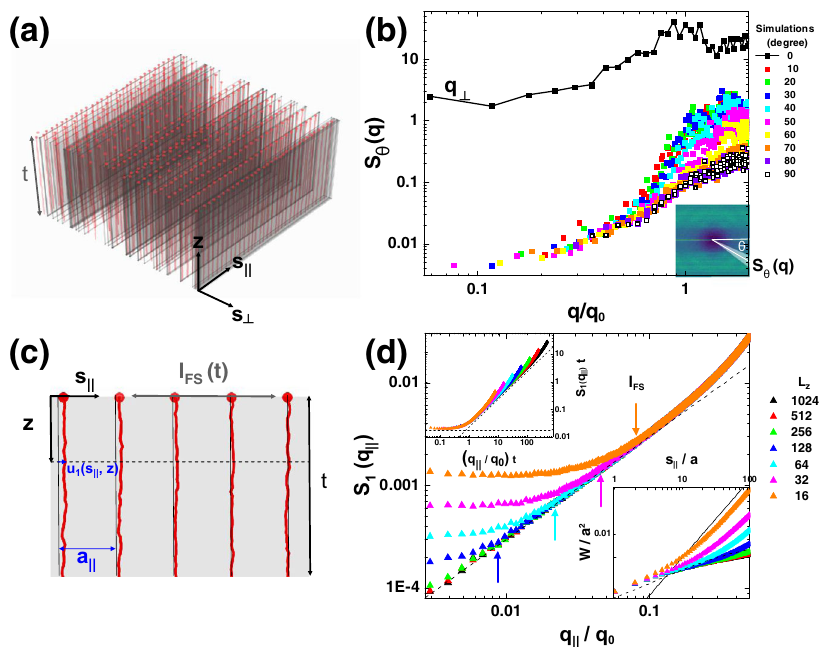
Fig. 5 Simulations of a structure of interacting elastic vortex lines in samples with planar defects. a Snapshot of a quenched con fi guration obtained from three dimensional Langevin dynamics simulations of interacting vortices (red lines) in presence of parallel randomly-located PD (gray planes). Circles highlight vortex tips at the sample surface. The coordinate system and the thickness are indicated. b Angular structure factor S θ ( q ) of the vortex positions at the sample surface for different angles θ indicated in the legend. The insert shows the S ( q x , q y ) data considered to calculate the curves in the main panel. c Schematics of the planar vortex row model indicating the displacement fi eld u 1 ( s ∥ , z ), the average spacing a ∥ for a perfect row with the same vortex density, and the characteristic thickness-dependent crossover length l FS . d Results for the con fi gurations of the planar vortex row at the surface of the sample ( z = 0) for different sample thicknesses proportional to the number of layers in the simulation L z . Main panel: S 1 ( q ∥ ) structure factor for different sample thicknesses. The dashed black line is a linear function. Arrows indicate the crossover behavior at q / q 0 ~ 1/ l FS . Bottom-right insert: Displacement correlator as a function of the distance along the row s ∥ . The full line is a linear function that reasonably describes the data in the large wavelength limit of thin samples whereas the dashed line is a logarithmic growth that follows the data at short wavelengths for thick enough samples. Top-left insert: Structure factor data S 1 ( q ∥ ) t vs. q ∥ t showing a scaling collapse and the two regimes separated by the crossover wavevector, 2 π / l FS ∝ 2 π / t